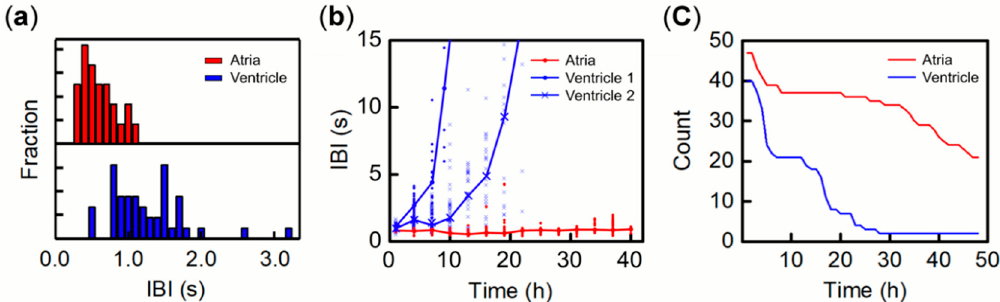
Figure 1. Beat activity of single fragments of atria (red) and ventricles (blue). ( a ) Statistics on inter-beat interval (IBI) of 1 h. ( b ) IBI transitions vs. time for representative fragments of atria (red) and two ventricles (blue). ( c ) Number of single fragments maintaining their beat activity vs. time for atria (red) and ventricles (blue).